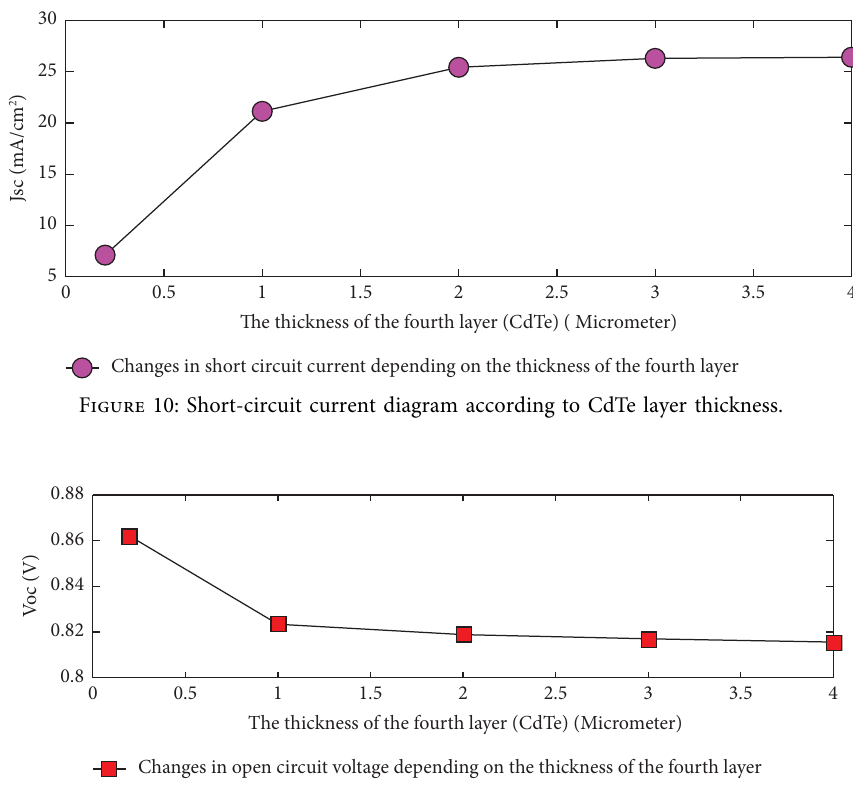
Figure 11: Open-circuit voltage diagram according to the thickness of the CdTe